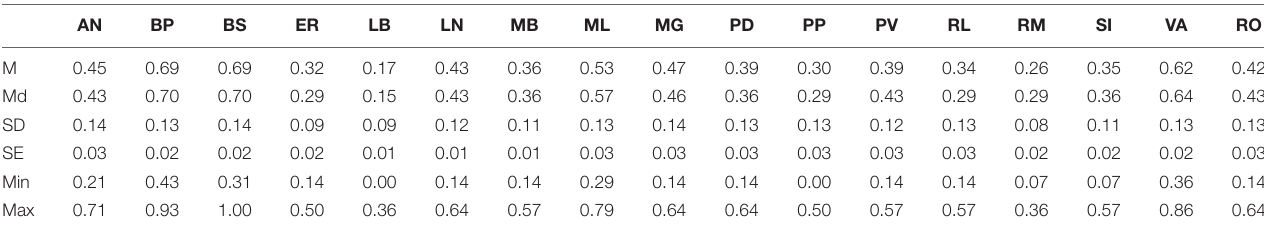
TABLE 2 | Breed mean Hind and statistical analysis.